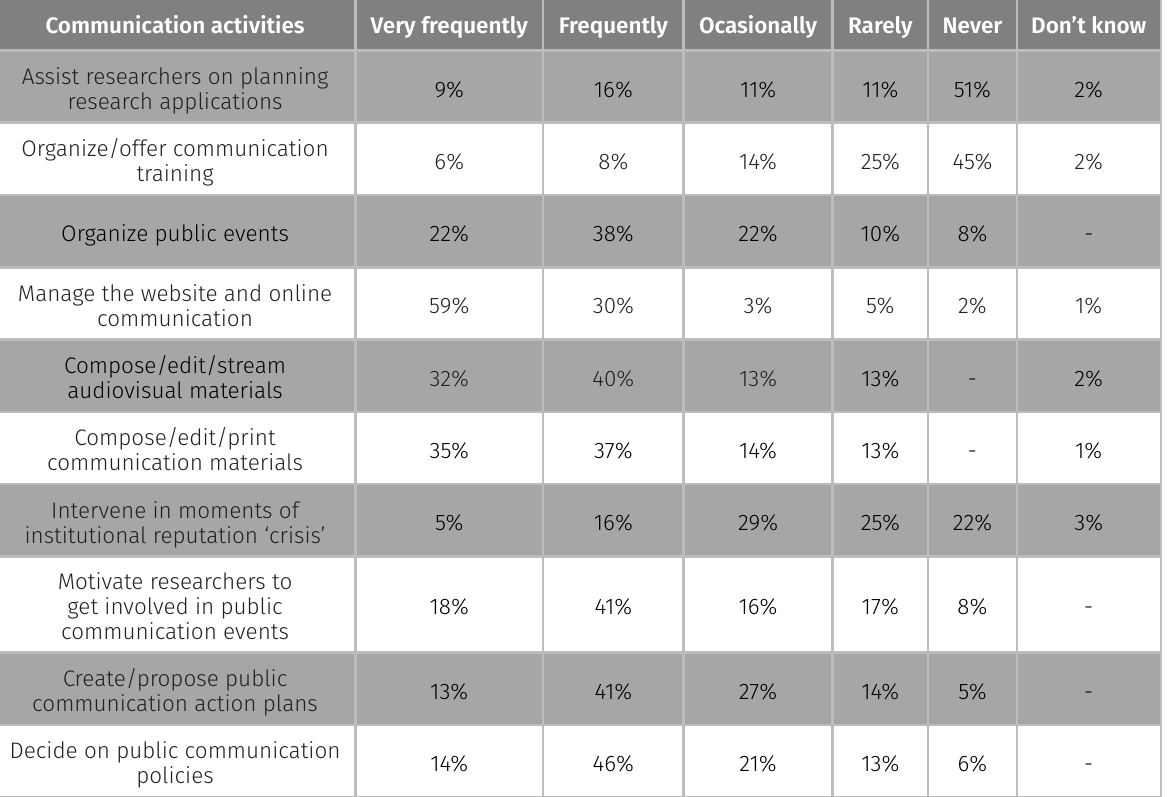
Table VI. Frequency of communication activities. Communication